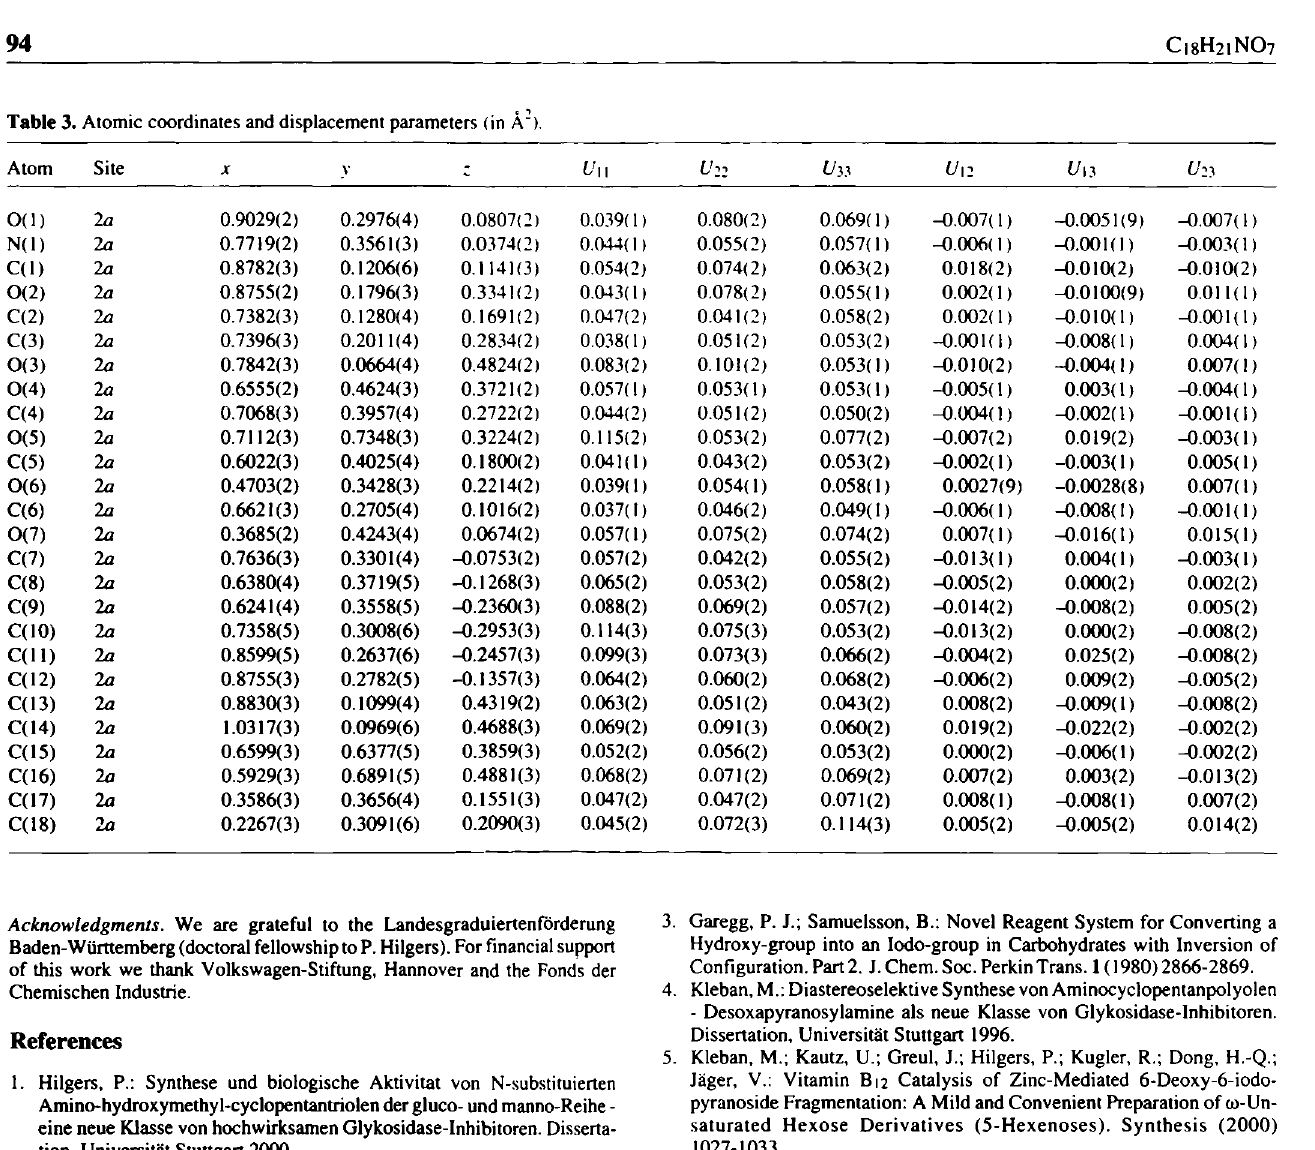
Table 3. Atomic coordinates and displacement parameters (in A") Atom